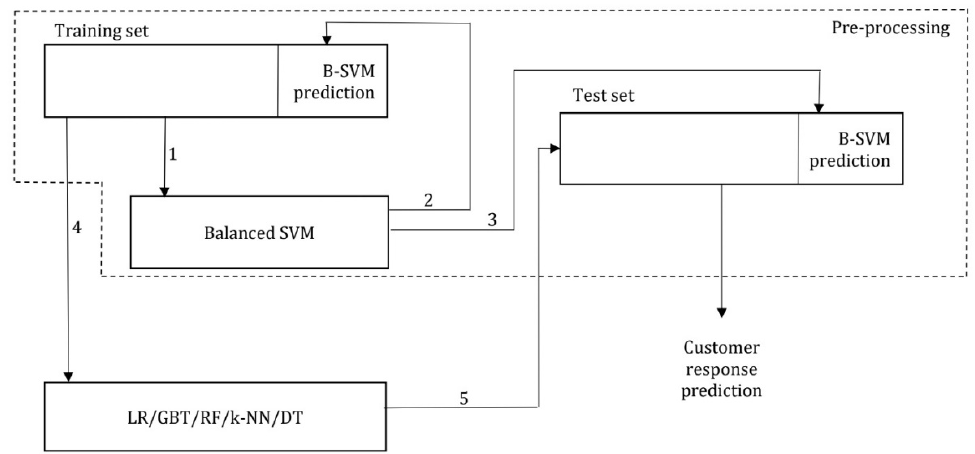
Figure 1. Predictive procedure illustration.